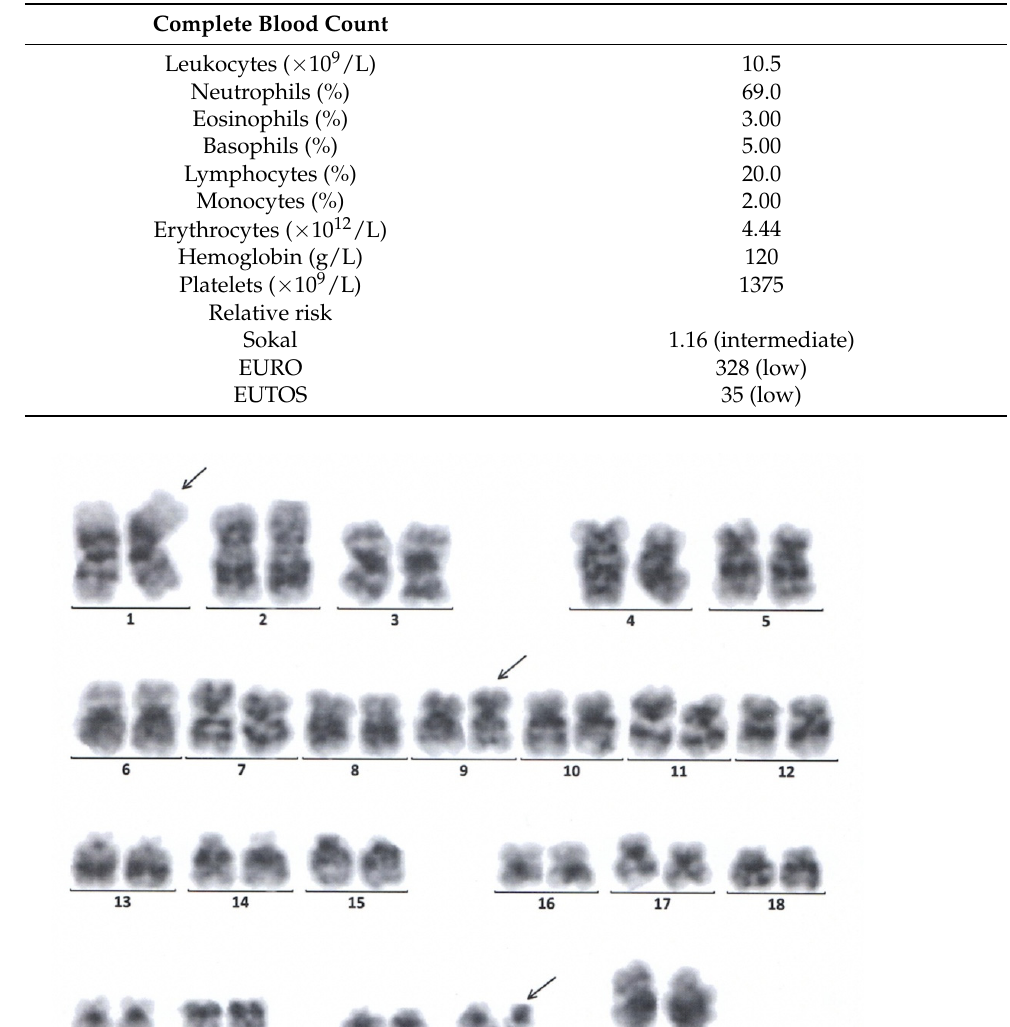
Table 1. The clinical characteristics of this patient at diagnosis.